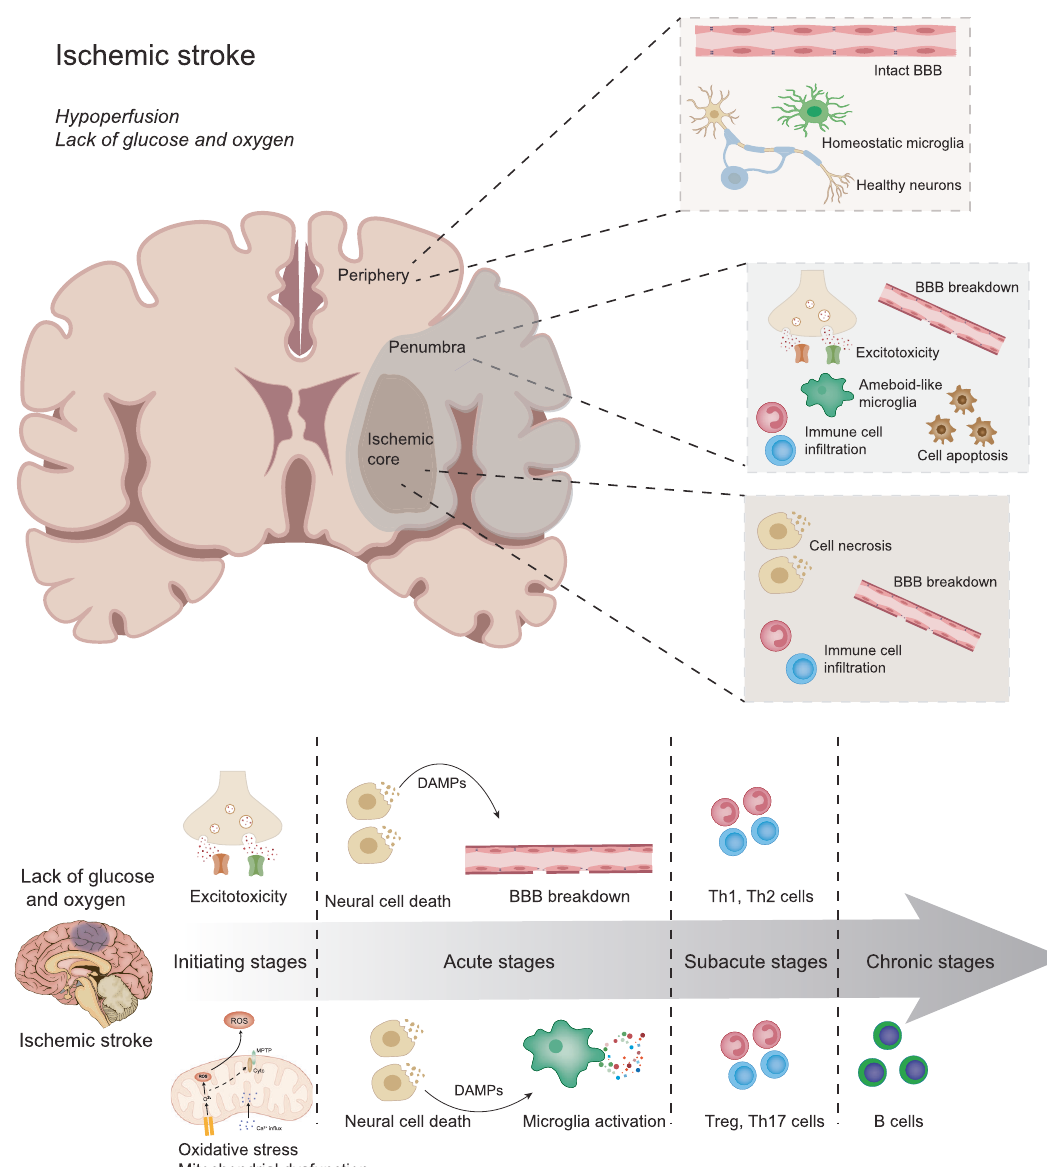
Fig. 1 Spatial and temporal relationships of the pathophysiology in ischemic stroke. BBB Blood-brain barrier, DAMPs Damage-associated molecular patterns, Th1 T-helper cell 1, Th2 T helper cell